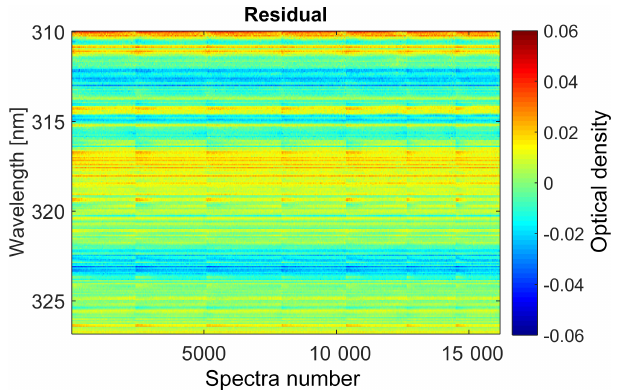
Figure 1. Time series of the residuals optical density (colour-coded) of a DOAS retrieval using a modelled background spectrum. The figure shows data from the 7 days (5–11 September 2010) used in the PCA (without SO 2 included in the fit) for instrument D2J2201 at Nevado del Ruiz. The residuals are shown in chronological order. The discontinuities in horizontal direction are at the transition from one day to another.